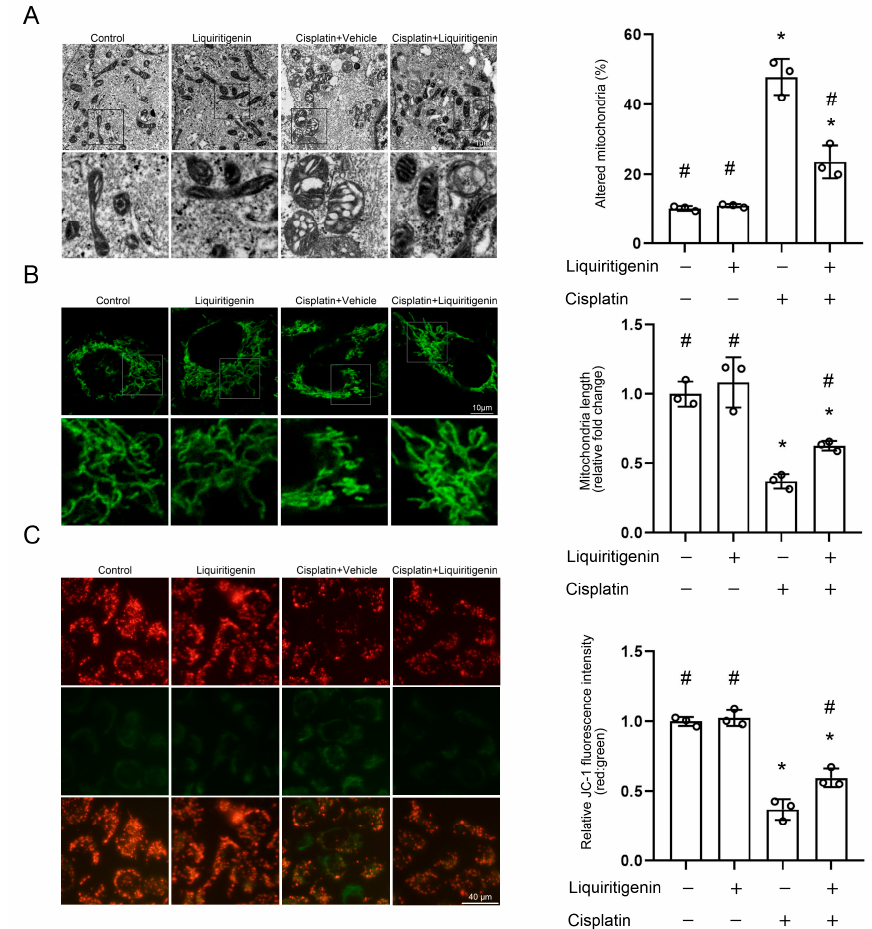
Figure 3. The effect of liquiritigenin on CP-induced mitochondrial damage. ( A ) Representative TEM images on the left showing mitochondrial morphology and mitochondria diameter of live cultured renal tubule epithelial cells with different treatments. Quantitative assessment of the percentage of altered mitochondria characterized by mitochondria swelling, vacuolization, and cristae fragmentation. * p < 0.05 vs. vehicle-control group, # p < 0.05 vs. CP treatment group. Data were obtained from three independent biological replicates. ( B ) Representative images for MitoTracker greens staining showing mitochondrial morphology and mitochondria length in live cultured renal tubule epithelial cells with different treatments. The results were normalized to the mitochondrial length of the vehicle-control group. * p < 0.05 vs. vehicle-control group, # p < 0.05 vs. CP treatment group. Data were obtained from three independent biological replicates. ( C ) Representative images of renal tubule epithelial cells stained with JC-1 showing changes in fluorescence intensity in live cultured renal tubule epithelial cells with different treatments. JC-1 fluorescence was normalized to the red-to-green ratio of the vehicle-control group. * p < 0.05 vs. vehicle-control group, # p < 0.05 vs. CP treatment group. Data were obtained from three independent biological